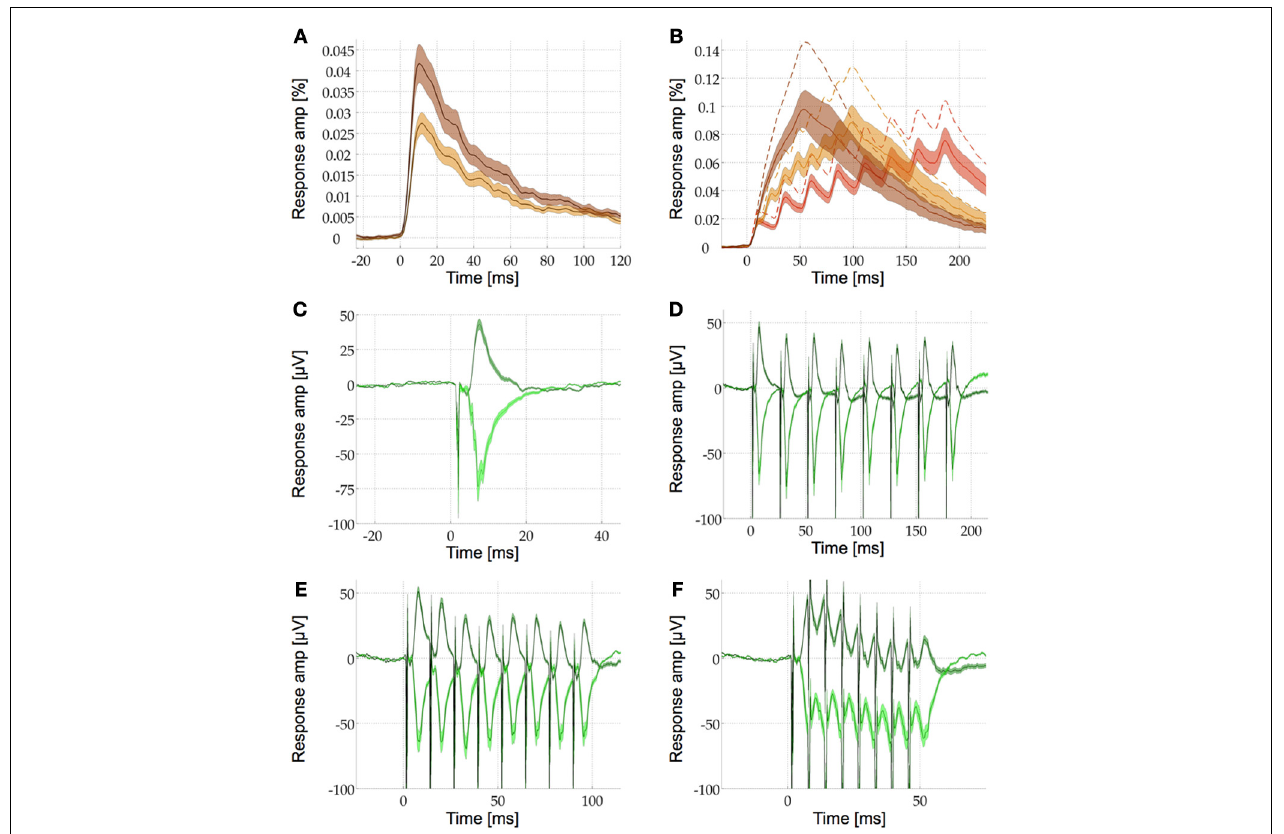
FIGURE 4 | Comparison of VSDI and LFP response profiles to stimulation with single pulses and pulse trains. (A) Single pulse response profile in the GL (brown) and the IGL (beige). See Results for details, the shaded area is the s.e.m. (B) IGL VSDI response profile for pulse train stimulation with eight pulses at 40Hz (red), 80Hz (beige), and 160Hz (brown). With increasing stimulation frequency the response amplitude increases and the individual pulses sum up into a smooth response envelope at 160Hz. For visibility only the IGL is shown in detail [same format as in (A) ], the mean responses in the GL are shown with